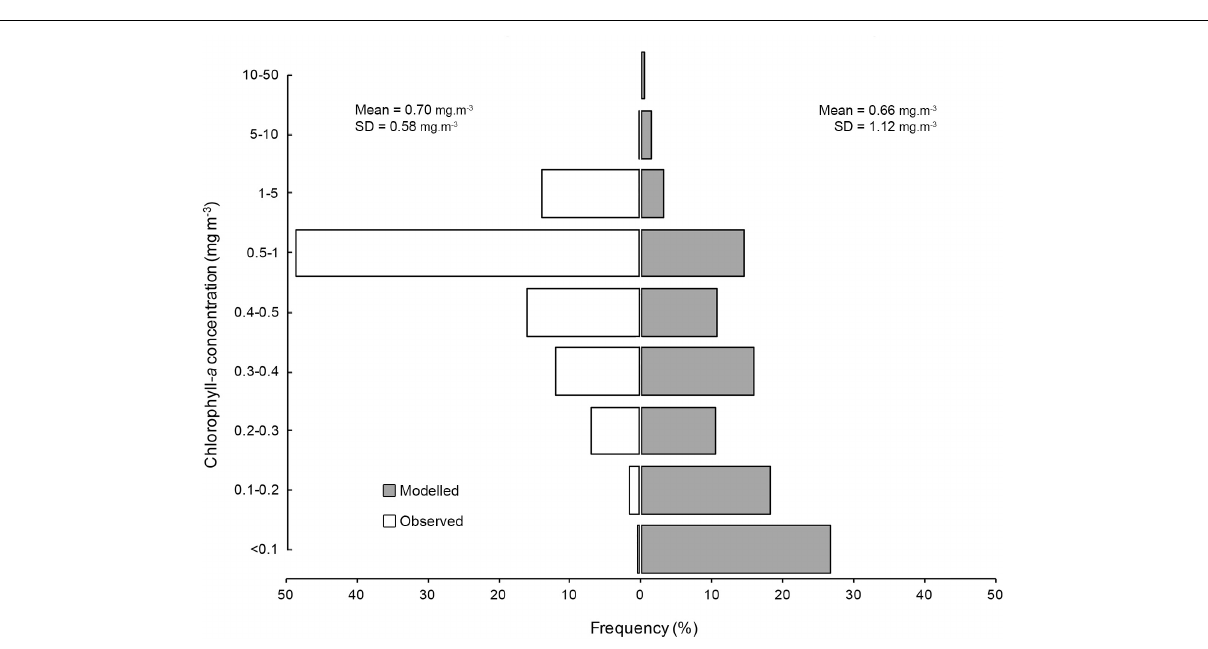
FIGURE 9 | Chlorophyll- a concentration preferences for satellite tracked M. alfredi (white) and modelled tag tracks